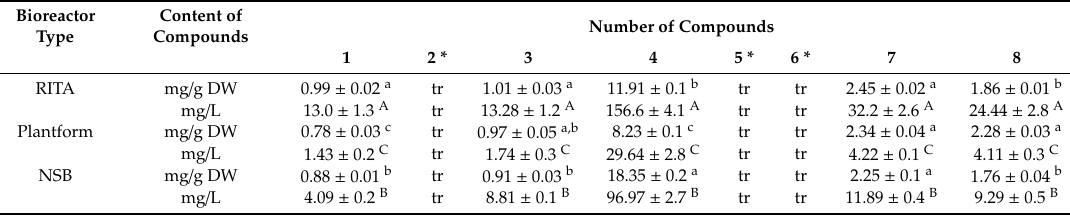
Table 2. Phenolic content in hydromethanolic extract of D. forrestii transformed shoots grown for 3 weeks in di ff erent bioreactor systems in MS medium with BPA 0.5 mg / L and IAA 0.2 mg /